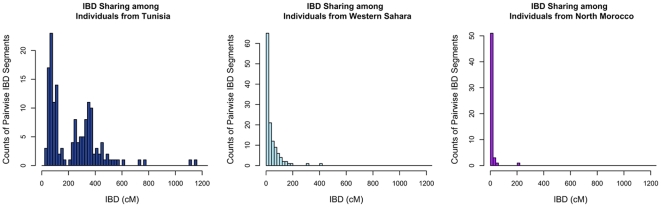
Distribution of long segments that are identical by descent (IBD) for pairs of individuals.The cumulative amount of DNA shared IBD between each pair of individuals within a population was summed. We display counts of the number of pairs sharing cumulative IBD in A) Tunisian Berbers, B) Saharawi and B) North Moroccans.